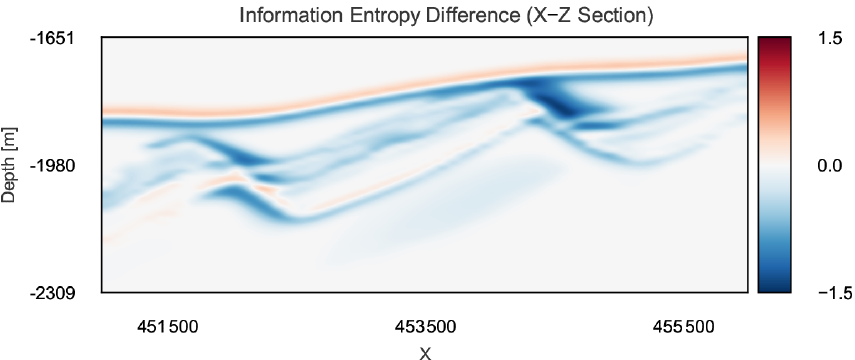
Figure 11. X–Z section of entropy difference between the forward-simulated entropy and the approximate posterior entropy H ( (cid:15) = 0 . 025). The plot highlights areas where the entropy was reduced (blue), increased (red) and kept constant (white).